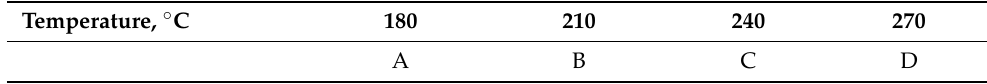
Table 3. Temperatures used for the preparation of the blends.